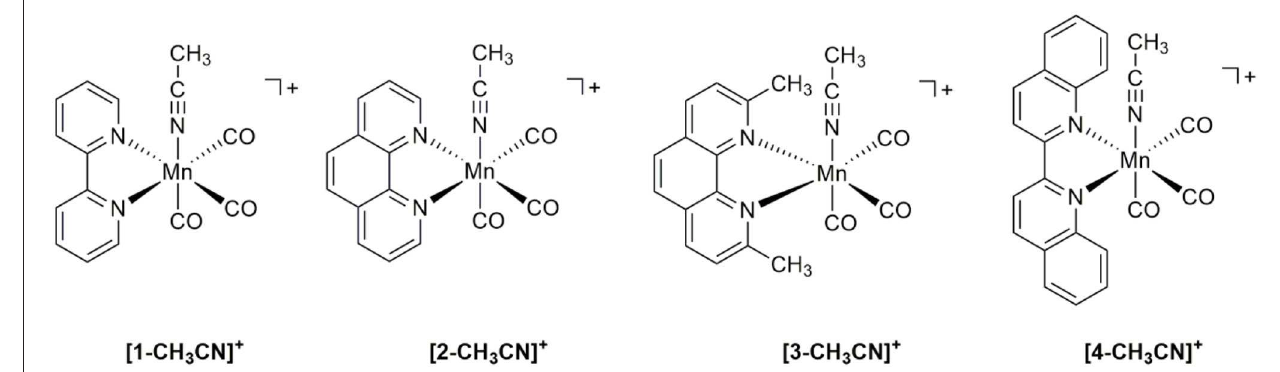
FIGURE 1 | Molecular structures of complexes investigated.